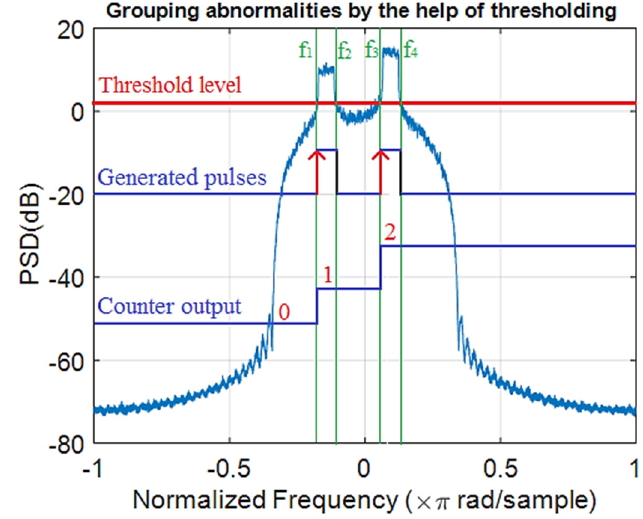
Figure 5. Simple scenario for grouping interferences.